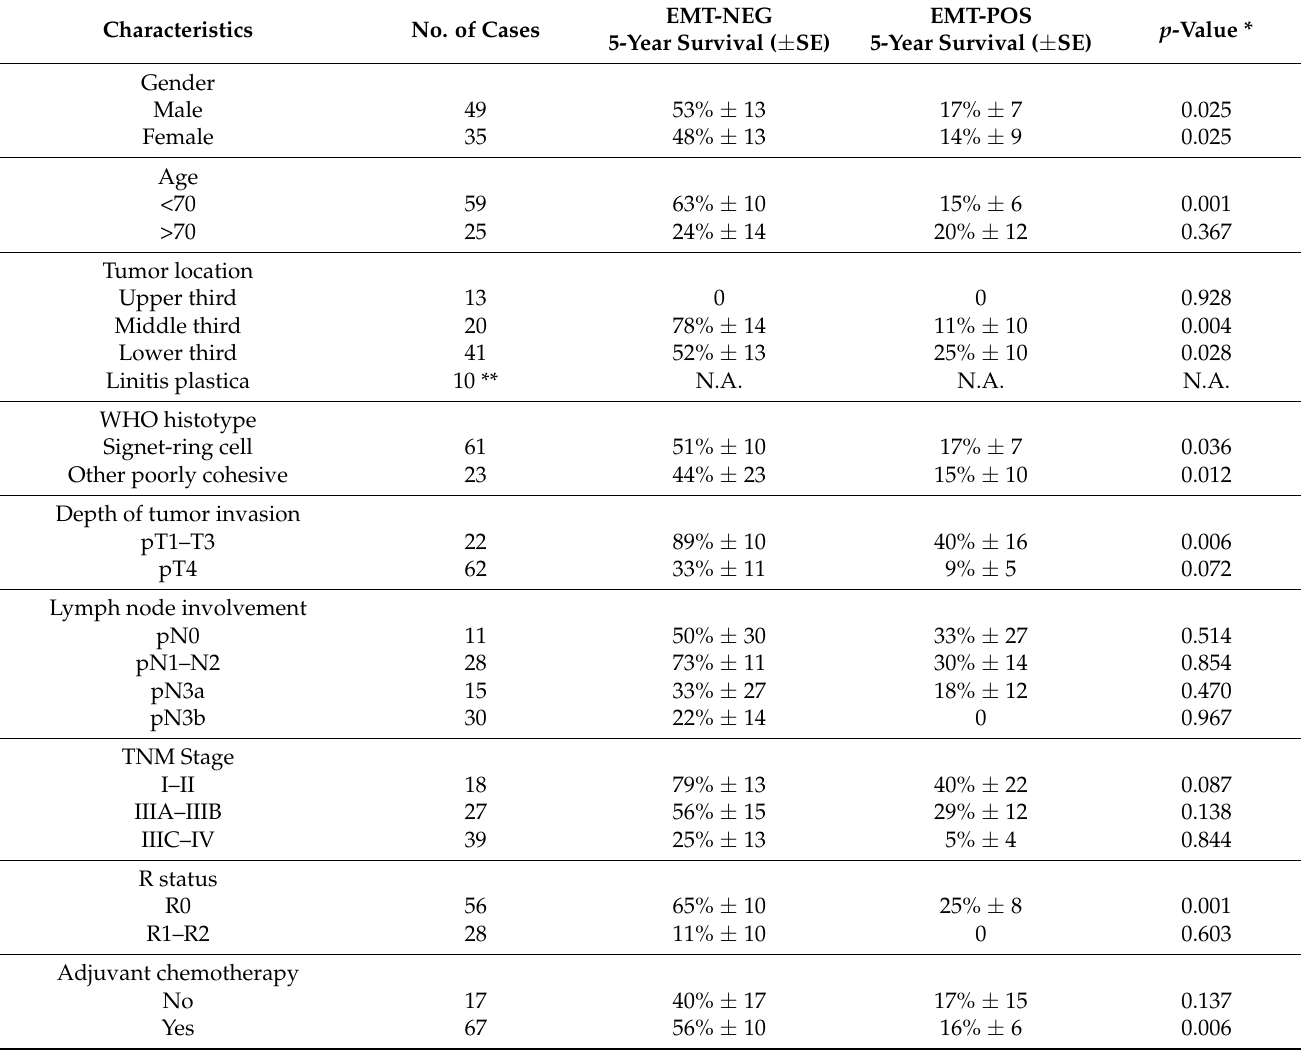
Table 2. Five-year cancer-specific survival probability according to EMT status, stratified for the main clinical-pathological factors.